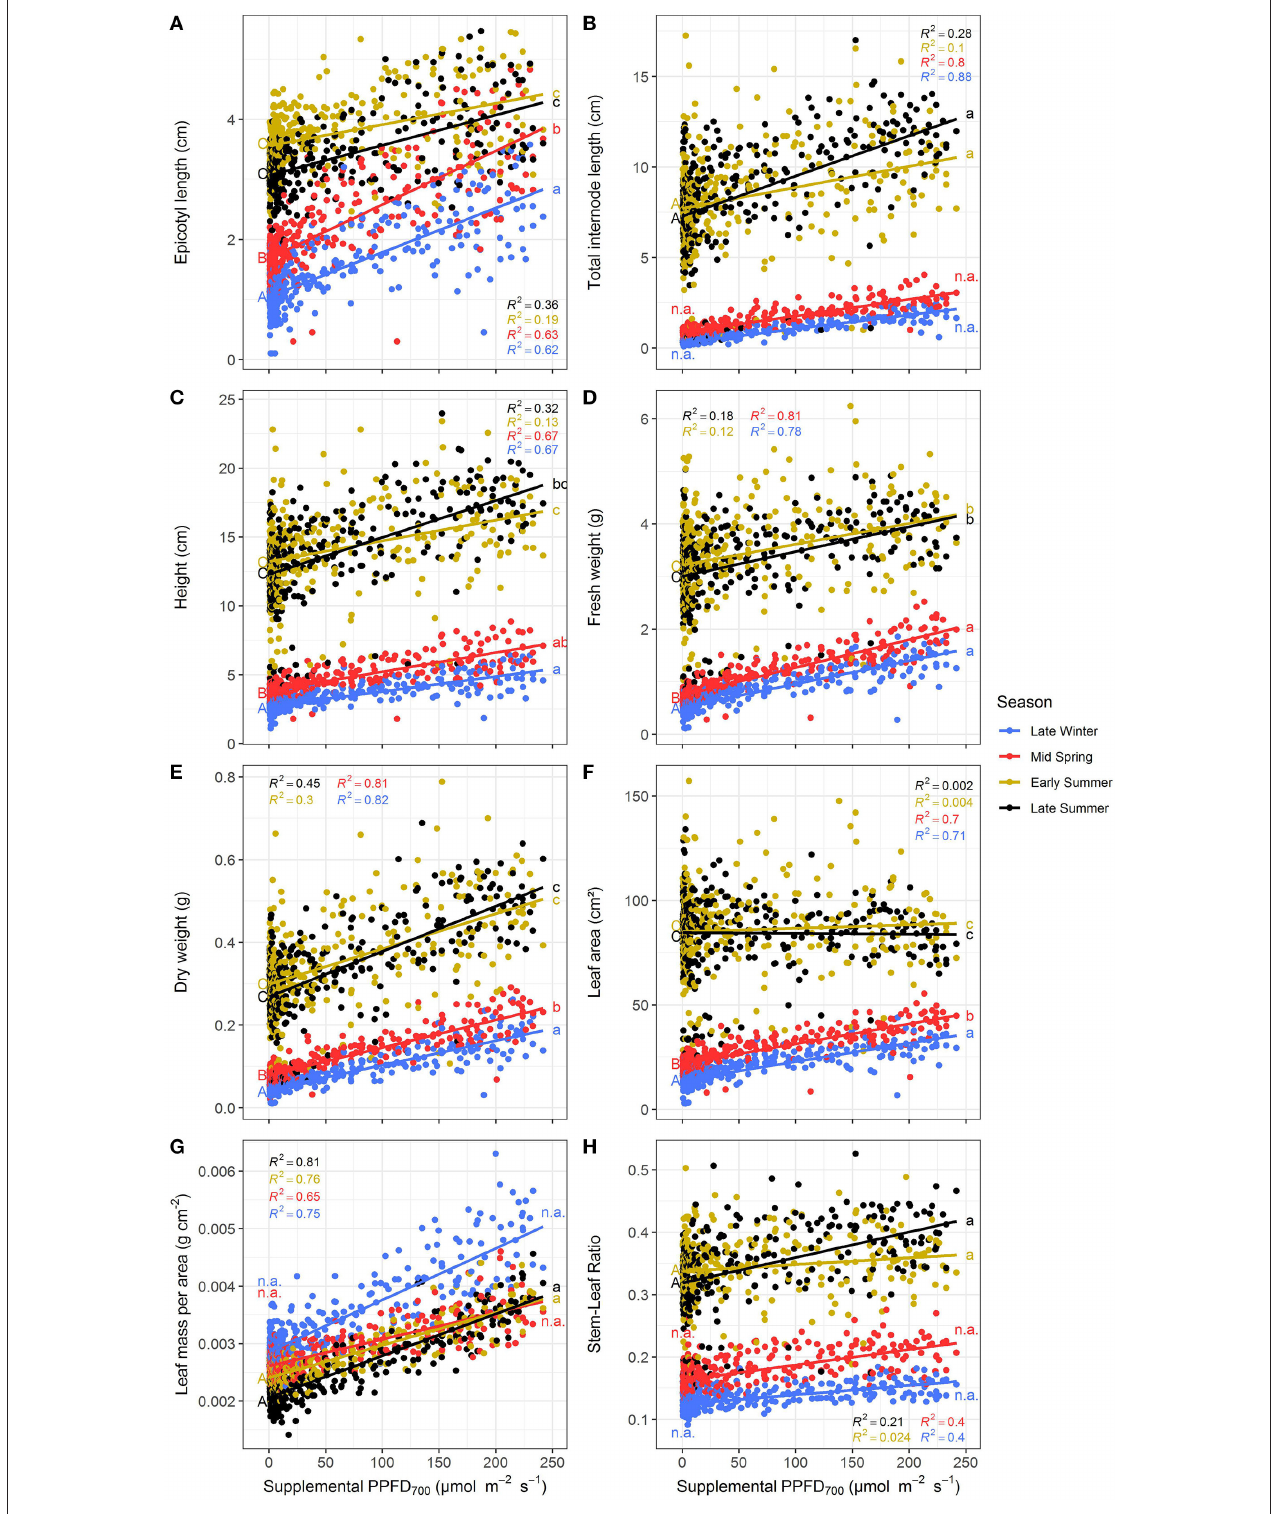
FIGURE 5 | Effect of the season on epicotyl length (A), total internode length (B) , height (C) , fresh weight (D), dry weight (E), leaf area (F) , leaf mass per area (G) , and stem-leaf ratio (H) of Ocimum basilicum L. cv. “Edwina” cultivated under greenhouse conditions. Different lower-case and upper-case letters indicate